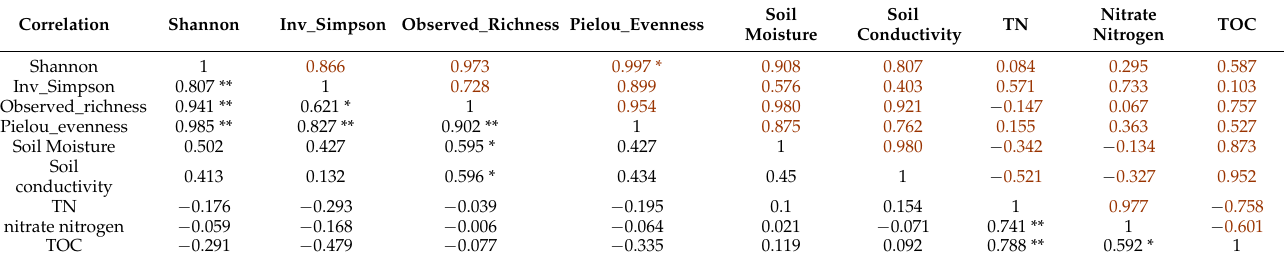
Table 5. Correlation analysis of soil physical and chemical properties and species diversity.